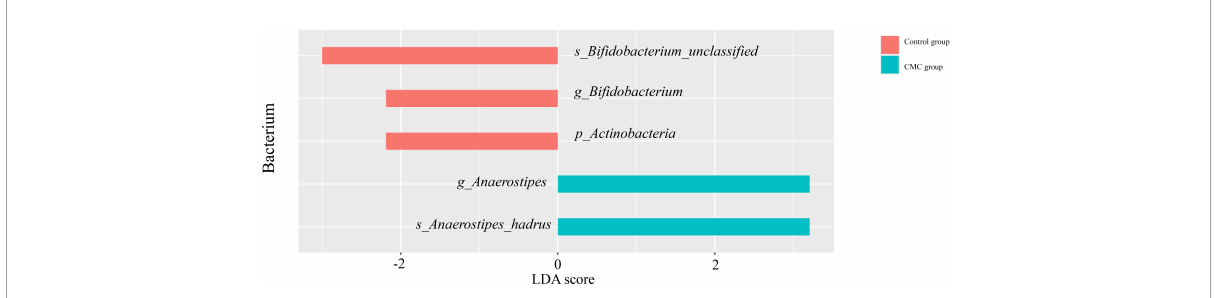
FIGURE3 Biomarkers identified by LEfSe. LEfSe indicates differences in the bacterial taxa at different levels (p, phylum; g, genus; s, species), only the taxa having P < 0.05 , FDR < 0.1, and LDA value > 2 are shown in the figure.